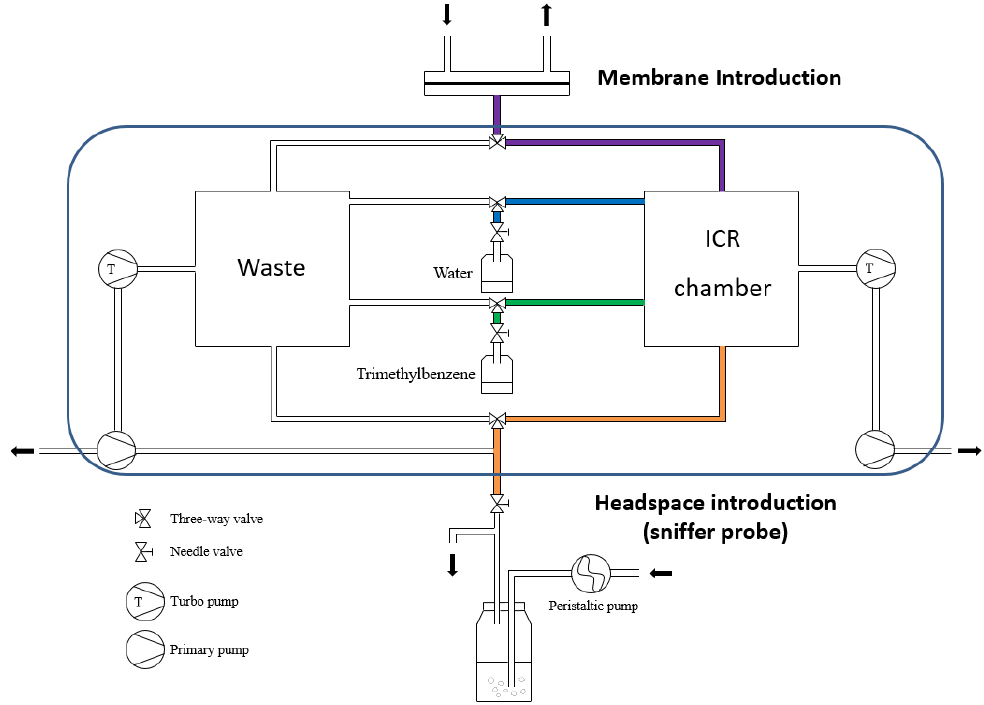
Figure 1. Diagram of the inlet system in the BTrap™ device.